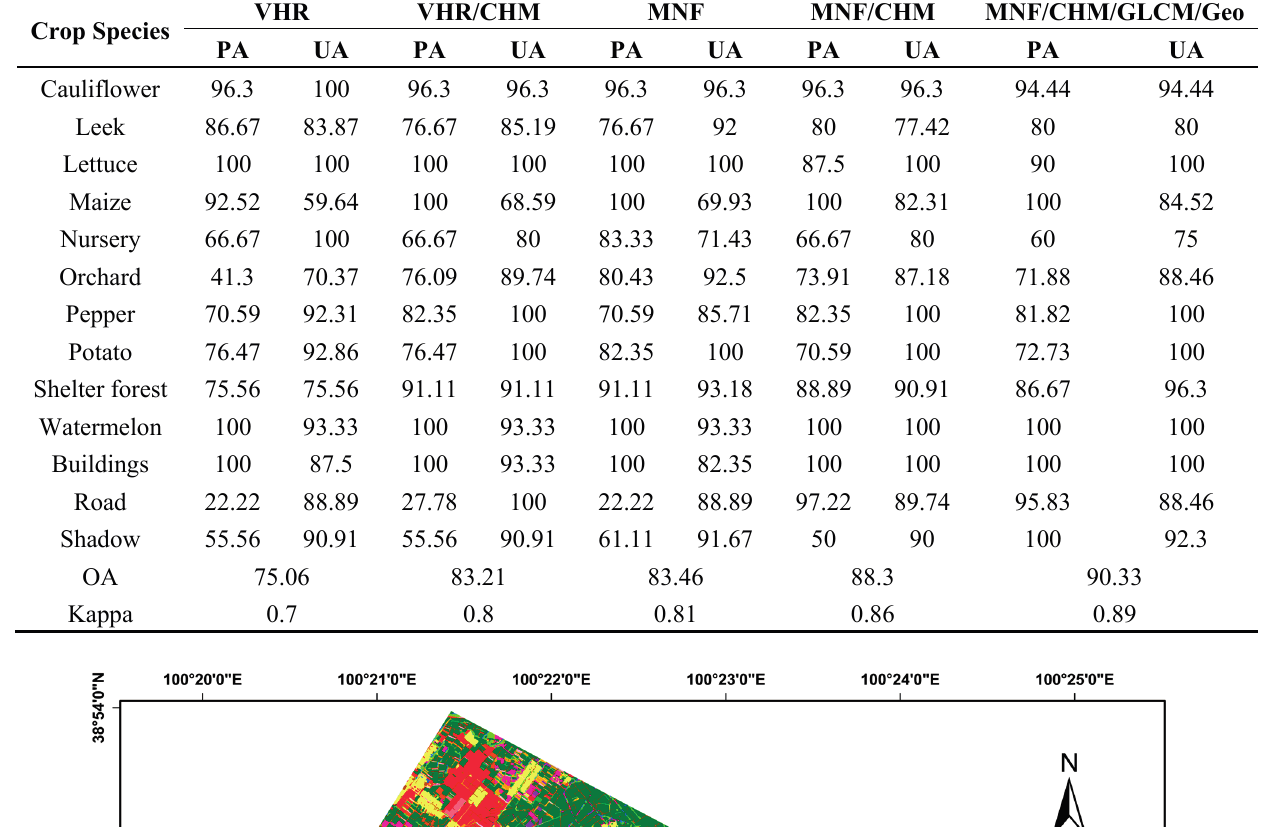
Table 7. Summary of classification accuracies of the different classification schemes. Crop Species